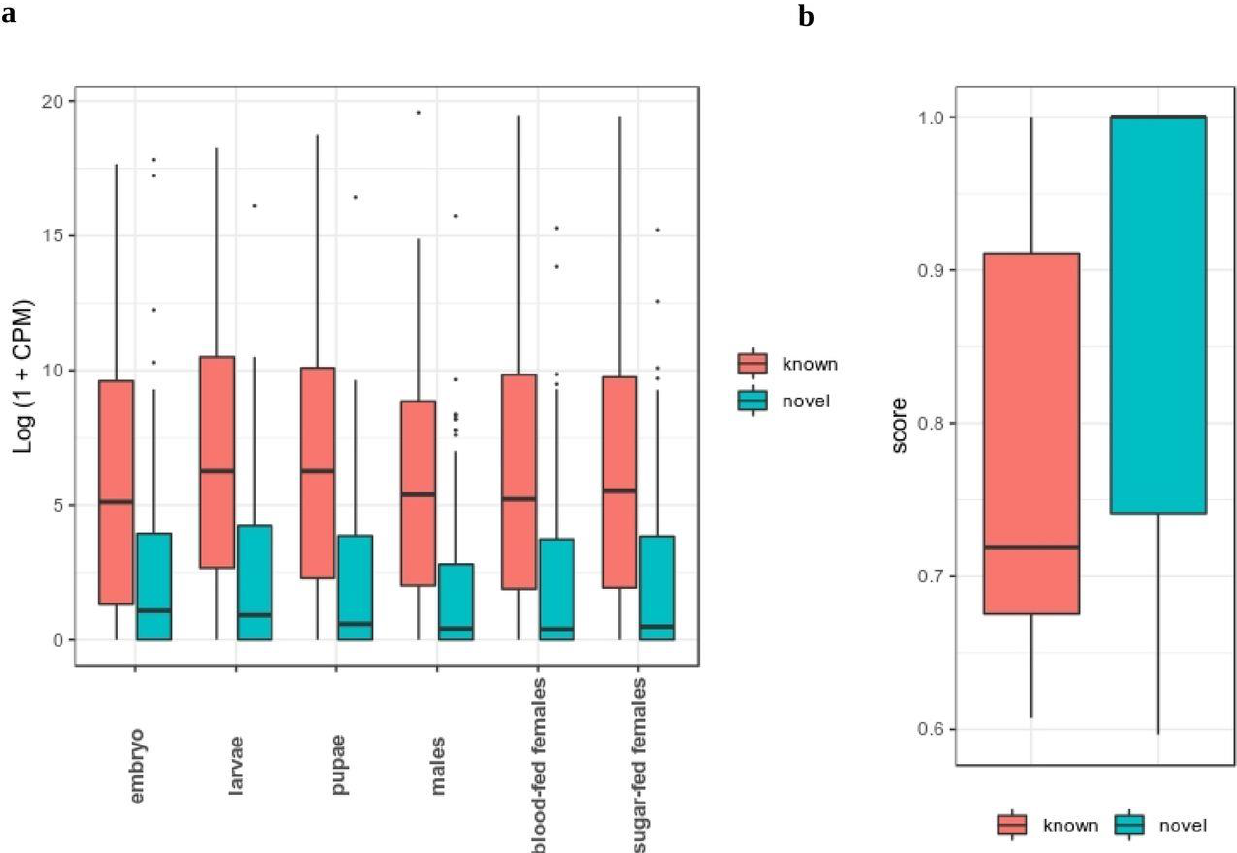
Figure 3. ( a ) Expression distribution of lncRNAs and protein-coding genes in Ae. albopictus. ( b ) Distribution of specificity score of lncRNAs and protein-coding genes in Ae. albopictus